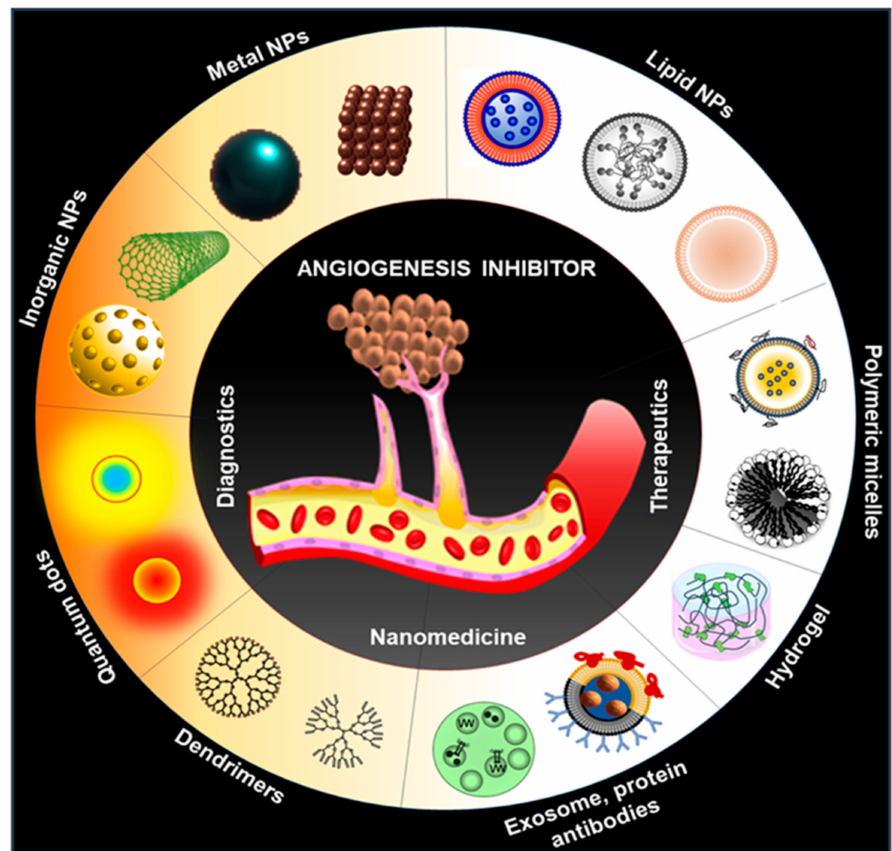
Figure 2. Schematic representation of multiple nanomedicine approaches that may be used for the diagnosis and treatment of